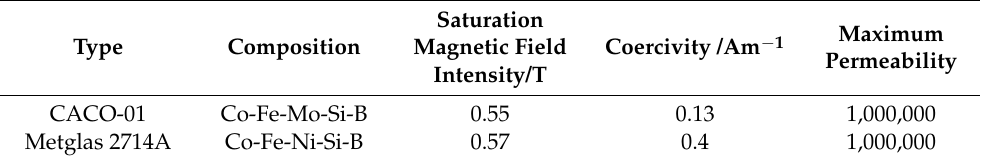
Figure 3. Co-based amorphous ribbon. Table 1. The magnetic parameters of CACO-01 and Metglas 2714A . Table 1. The magnetic parameters of CACO-01 and Metglas